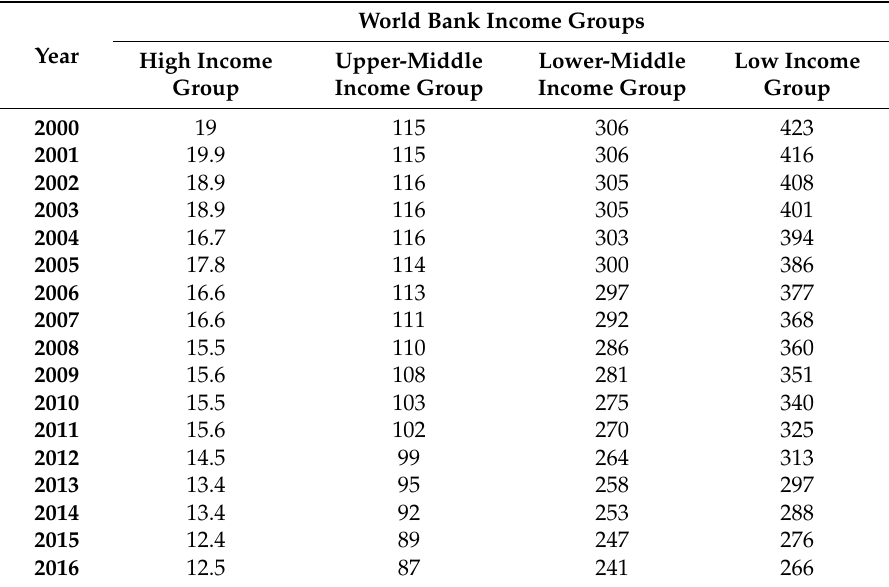
Table 3. Tuberculosis prevalence rates for the four income groups from 2000 to